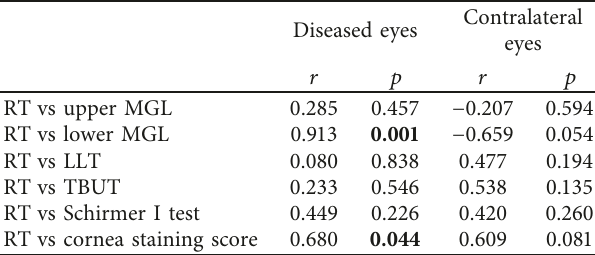
Figure 2: Acute and chronic changes of the bilateral lower meibomian gland after unilateral radiotherapy. Lower eyelid meibography of both eyes of a 33-year-old female with right conjunctival MALToma before (a, b), 3 days after (c, d), and 1 year (e, f) after right orbital radiotherapy. The changes of the meibomian gland structure of the diseased eye are shown in (a), (c), and (e), while the contralateral eye in (b), (d), and (f). Part of the meibography was blocked by the conjunctival tumor ( ∗ ) before radiotherapy (a). Prominent meibomian gland shrinkage was found 3 days after radiotherapy not only in the diseased eye (c) but also in the contralateral eye (d). Most of the meibomian gland structure recovered 12 months after radiotherapy with more prominent meibomian gland loss in the diseased eye (e) and mild meibomian gland loss in the contralateral eye (f). MALToma: mucosa-associated lymphoid tissue lymphoma. Table 3: Correlation analysis between the RT dosage and ocular surface parameters (Spearman rank